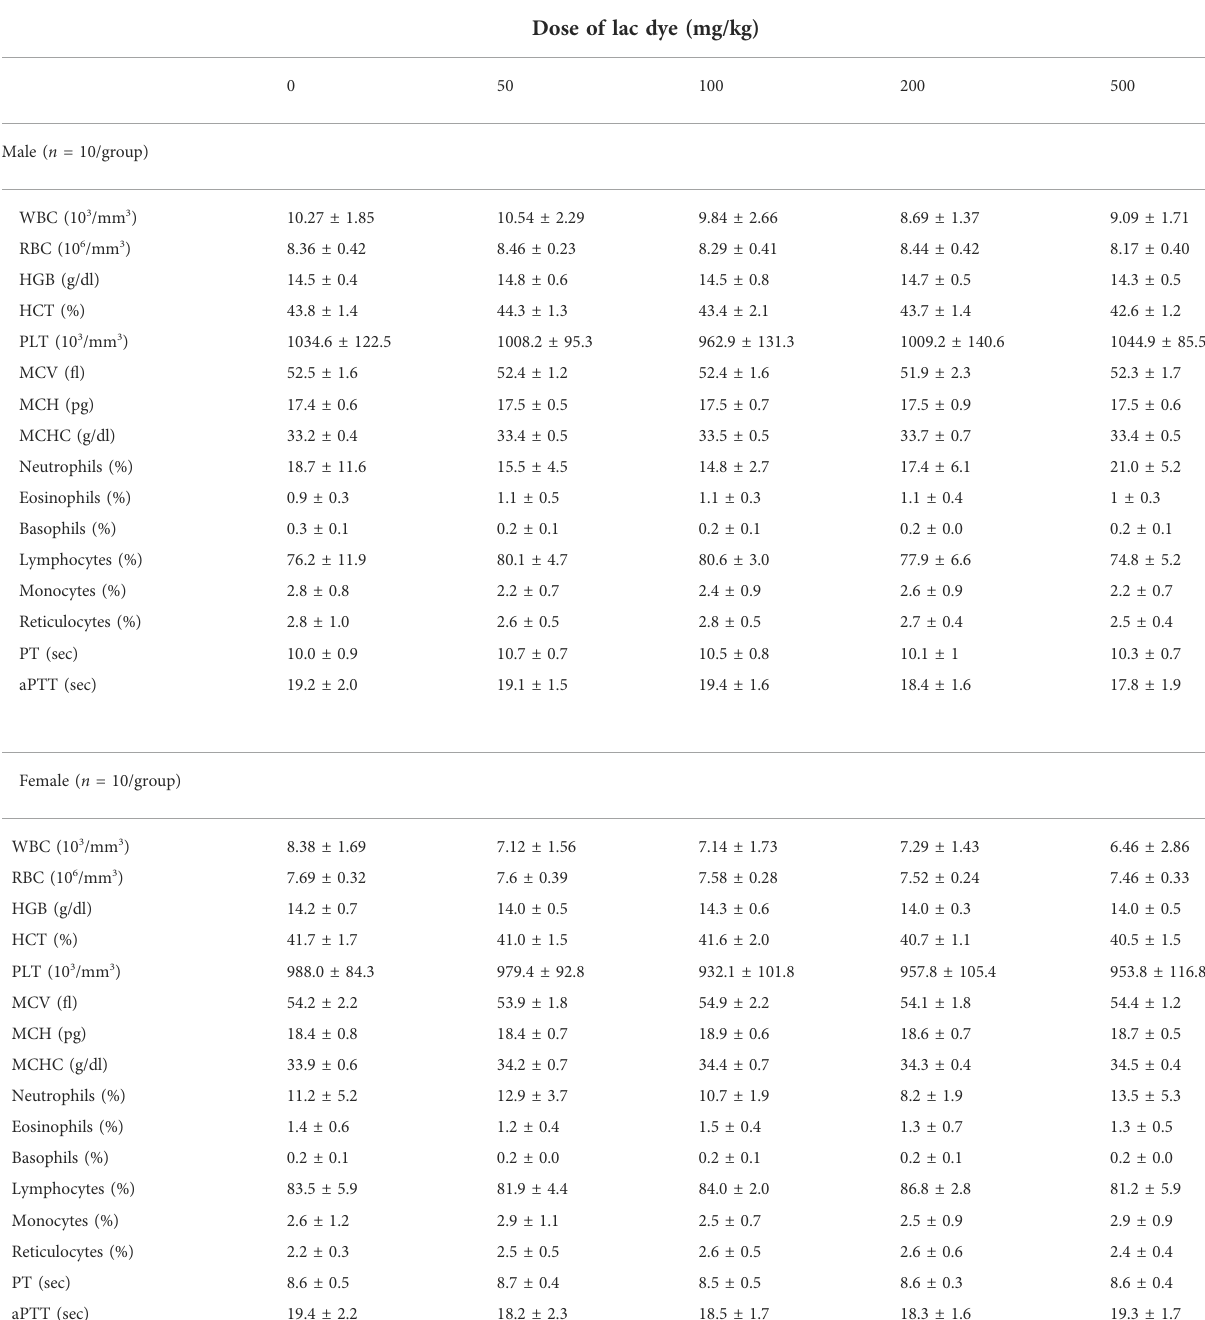
TABLE 1 Hematological parameters of SD rats orally treated with lac dye for 90 days.